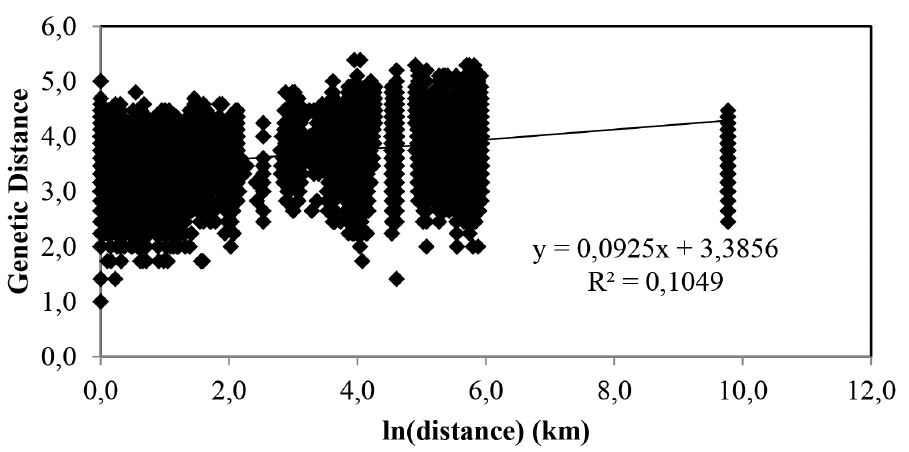
Figure 2. Mantel test for isolation by distance between individual crocodiles in all localities. No isolation by distance was observed (p=0.92). Rousset’s distance (F/(1-F)) was used for genetic distance. Geographic distance was the log of a straight line distance (km) between